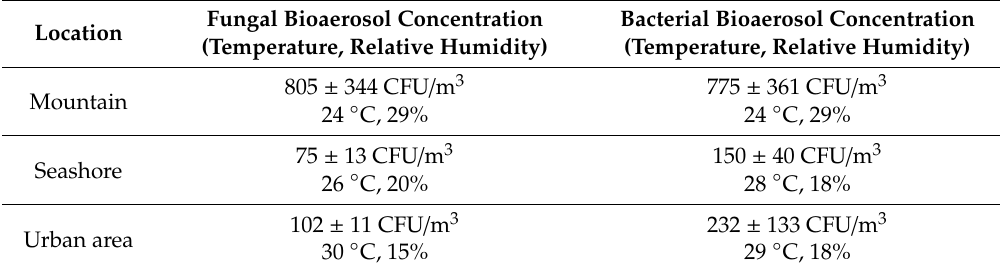
Table 1. Concentrations of culturable bioaerosol particles (April).